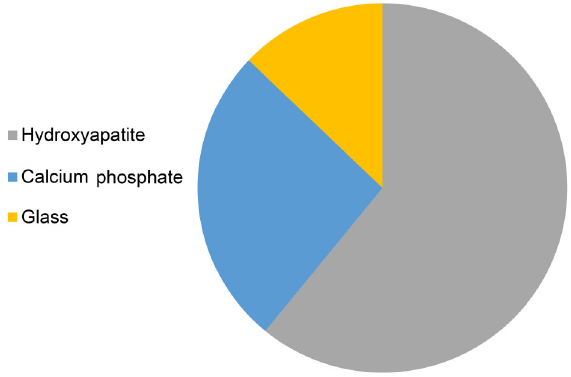
Figure 4. Graph showing ceramic distribution in publications retrieved from a search in the PubMed database using